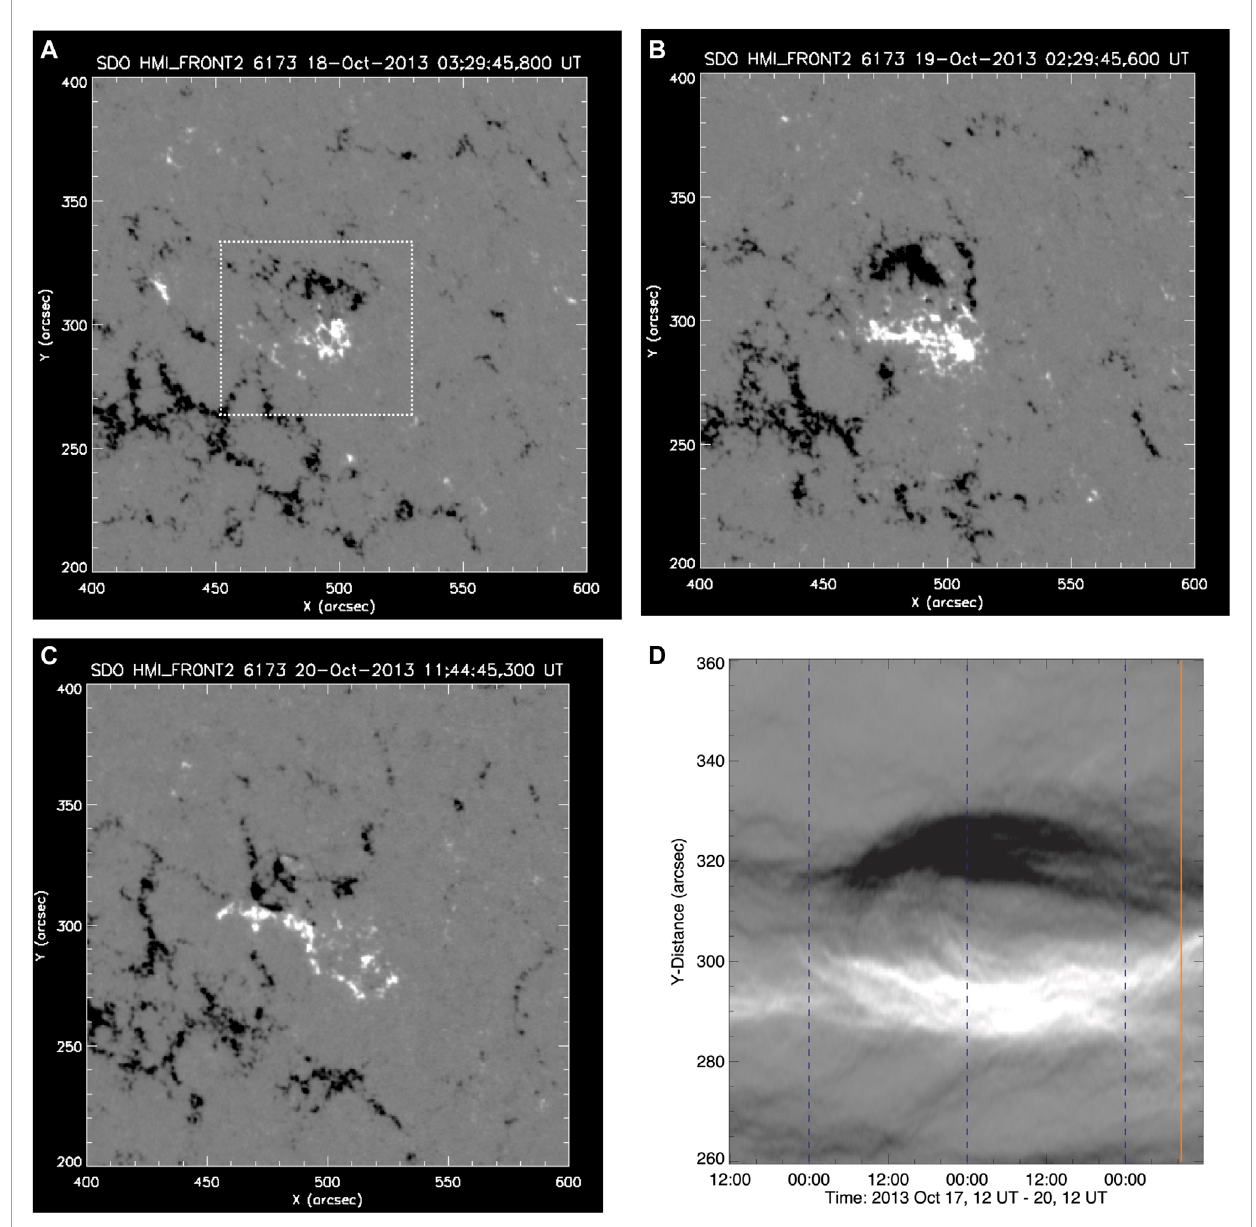
FIGURE 4 SDO /HMI magnetograms showing the evolution of a small-sized active region, NOAA AR 11868, which started emerging on 2013 October 16, and which produced a C-class flare and expelled a CME four days later on October 20. (A) The boxed region shows the emerging bipolar region about two days after the start of emergence. Black/white indicate negative/positive magnetic polarities. (B) The main negative and positive patches of the emerging region continue to grow and spread apart. (C) Portions of the opposite-polarity patches have converged on each other, and mangnetic cancelation is occurring between them. (D) A time-distance plot showing evolution of the two polarity patches of the region. This plot is formed by summing fluxes in the horizontal direction across the box in (A) , and the y-axis of this panel is a sub-portion of the y-axis of panels (A–C) . (From Sterling et al.,